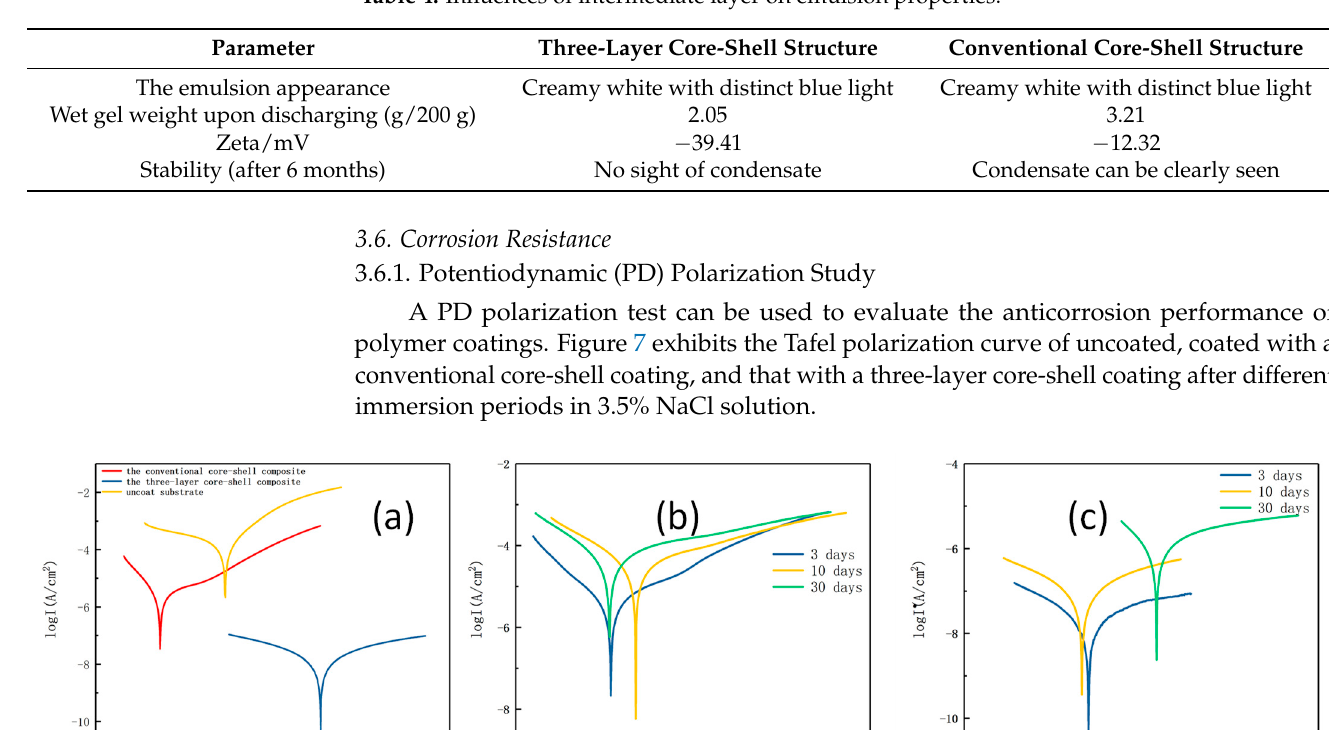
Table 4. Influences of intermediate layer on emulsion properties.